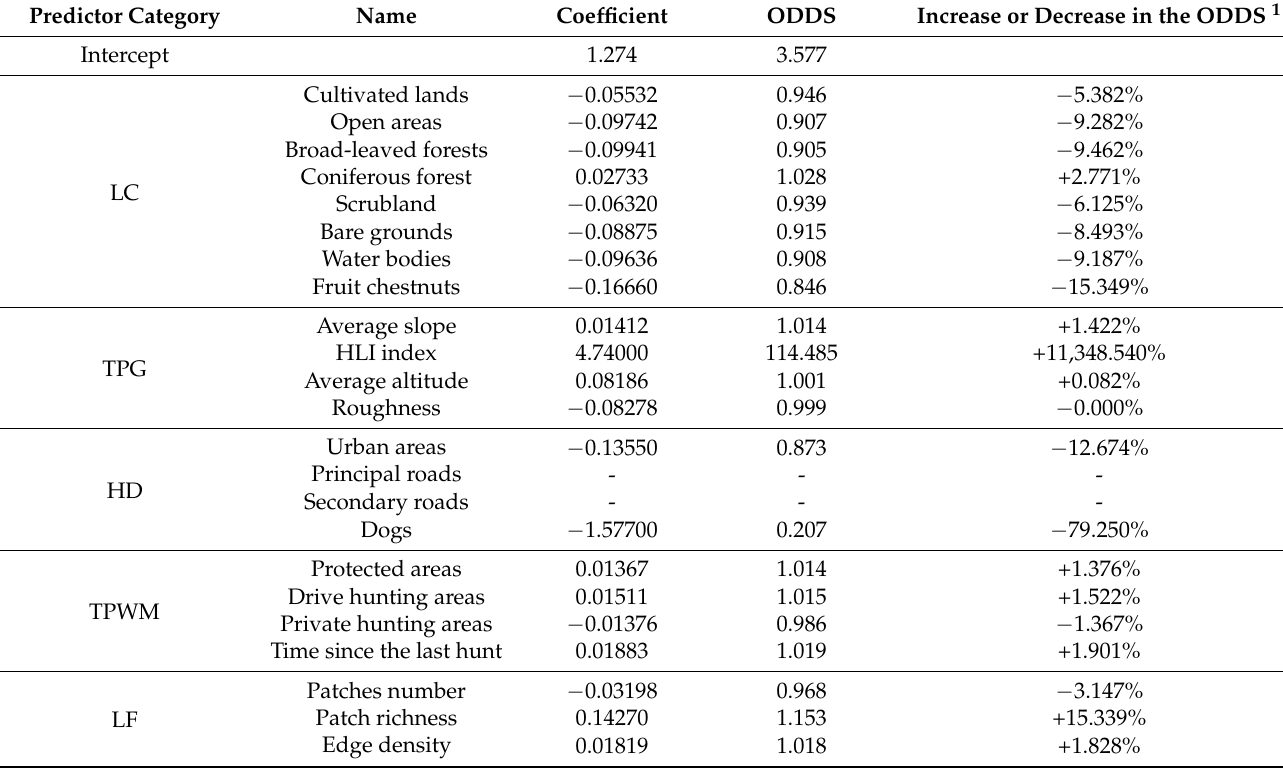
Table 7. Logistic LASSO regression-estimated coefficients and their ODDS-based